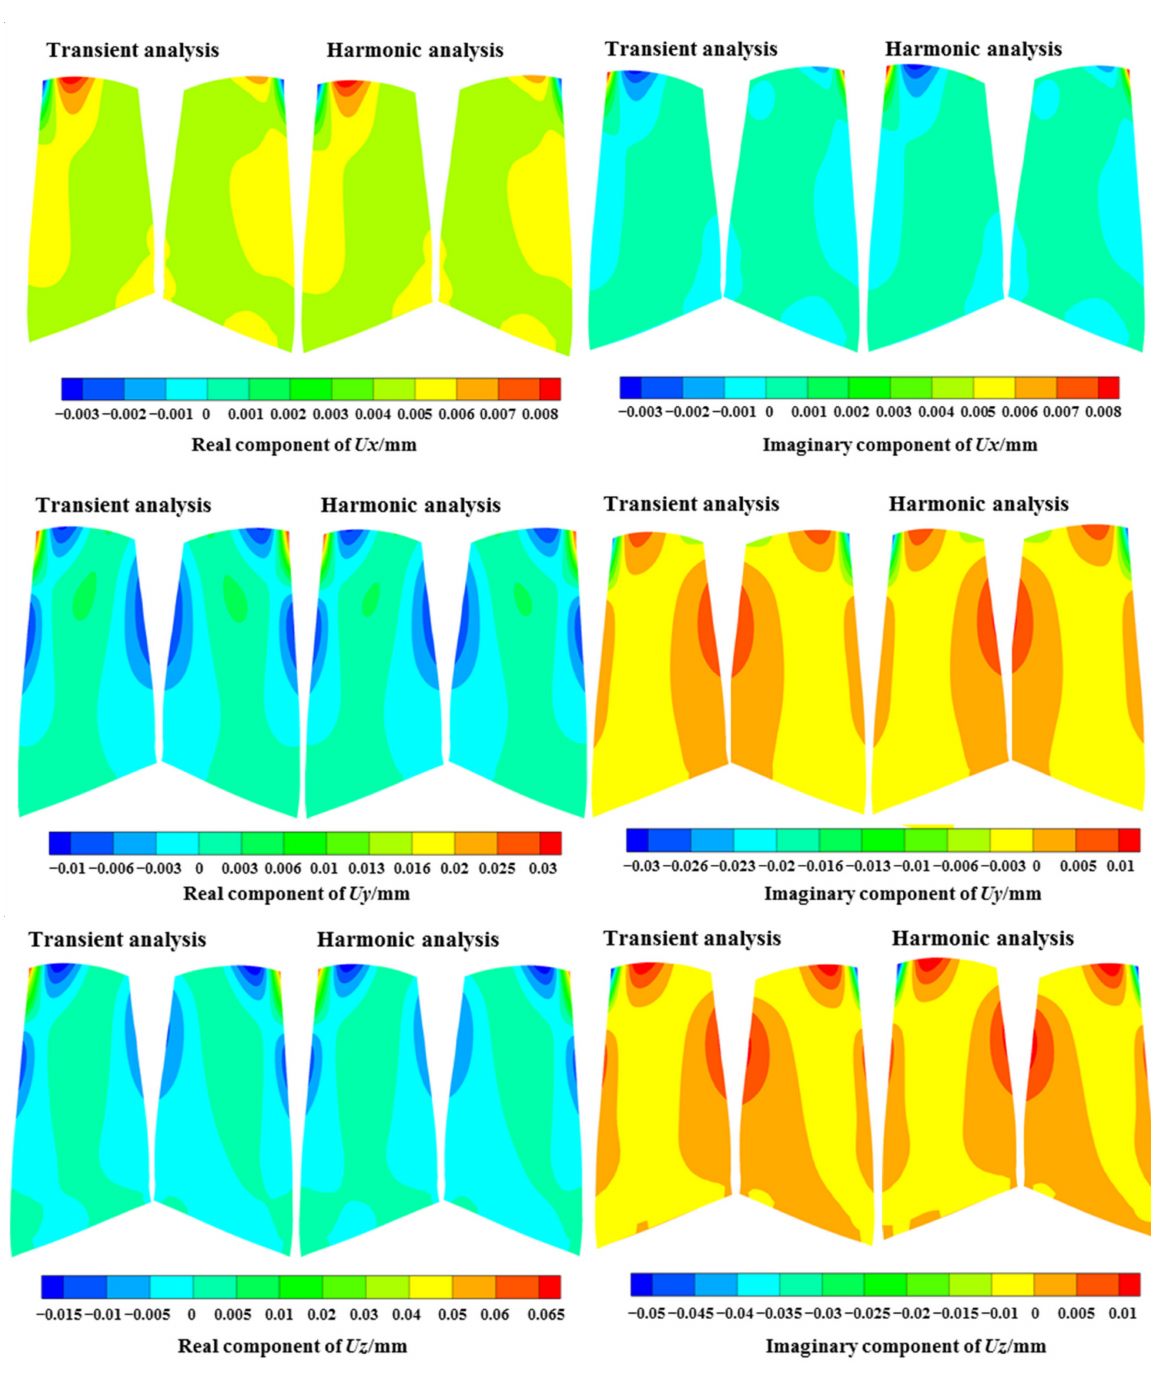
Figure 20. Comparison of the displacement